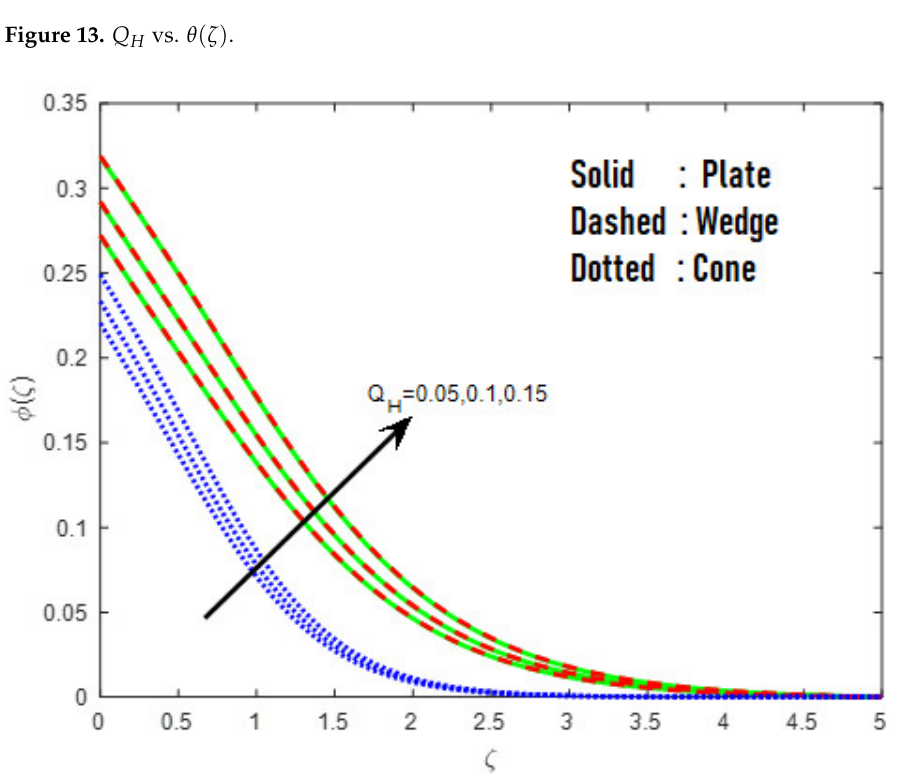
Figure 14. H Q vs.     . Figure 14. Q H vs. φ ( ζ )